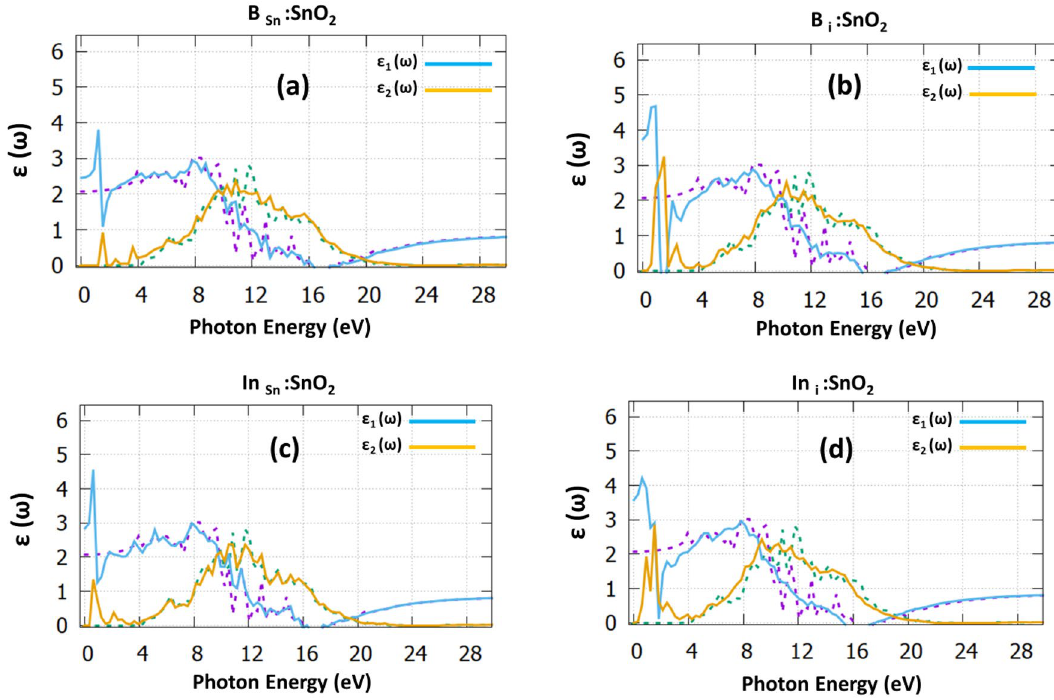
Figure 3. The dielectric function for ( a ) B Sn :SnO 2 , ( b ) B i :SnO 2 , ( c ) In Sn :SnO 2 and ( d ) In i :SnO 2 . The dotted purple and dotted green, correspond to the dielectric function of the undoped SnO 2